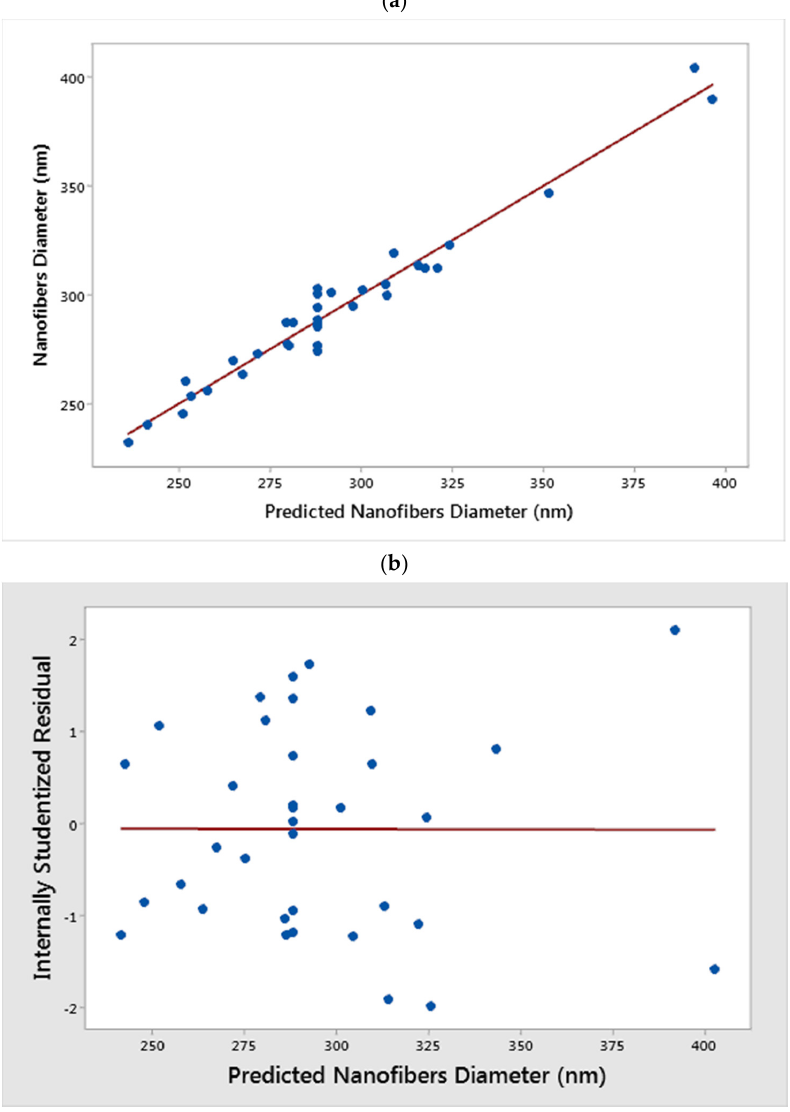
Figure 3. Validation of the nanofibers diameter model using ( a ) observed experimental data versus predicted values ( b ) internally studentized residuals versus predicted